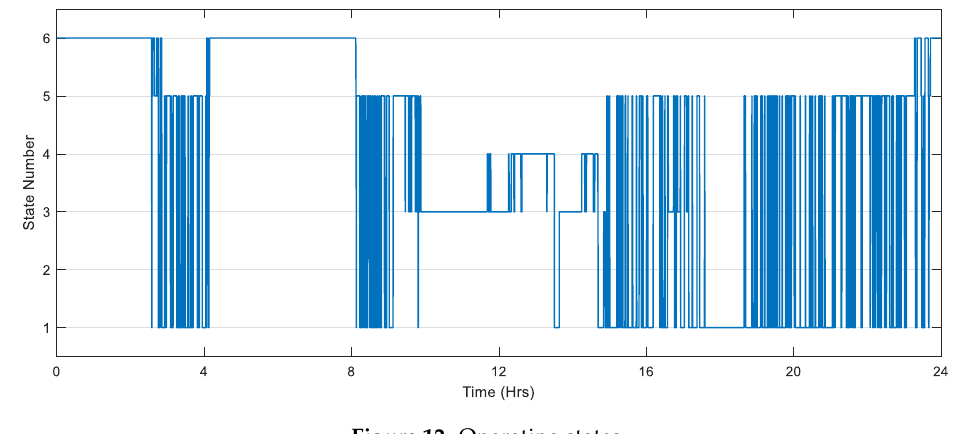
Figure 12. Operating states.